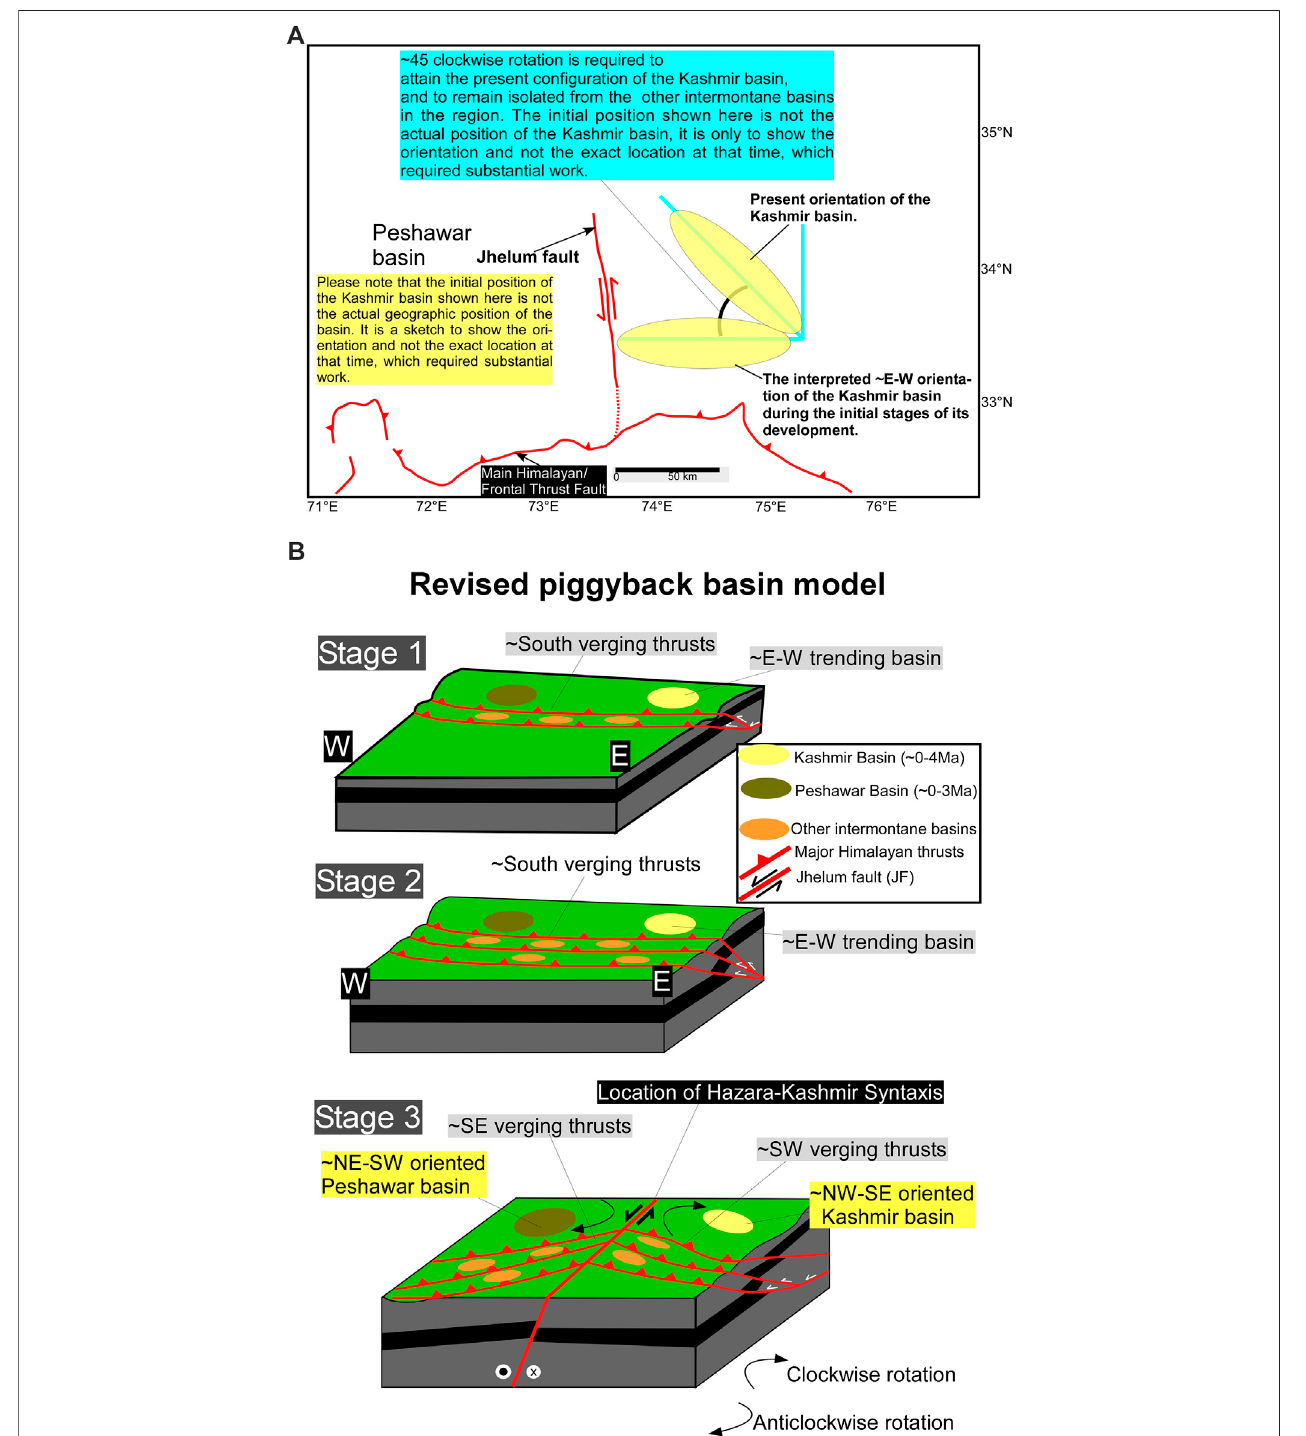
FIGURE 13 | The initial orientation of the Kashmir basin could have been ∼ E – W and later doing the emergence of Jhelum fault the basin was potentially translated and rotated ∼ 45 ° clockwise to acquire the present ∼ NW – SE structural con fi guration (A) . The revised piggyback basin model for the formation of Kashmir and Peshawar basins is presented (B) . Stage 1: the formation of the internal Himalayan thrust system (MBT, MHT) and intermontane basins (Kashmir, Peshawar, and other similar basins. Stage 2: shows the formation of the main frontal thrust, and other younger intermontane basins. Stage 3: the formation/reactivation of Jhelum fault system resultedin ∼ 45 ° clockwiserotationofKashmirandotherbasins,whicharenowlocatedattheeastoftheHazara-Kashmirsyntaxis,andanticlockwiserotationofthoseat the west.